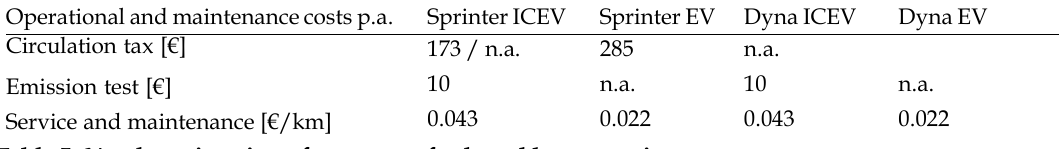
Table 5. Yearly estimations for energy, fuel, and battery